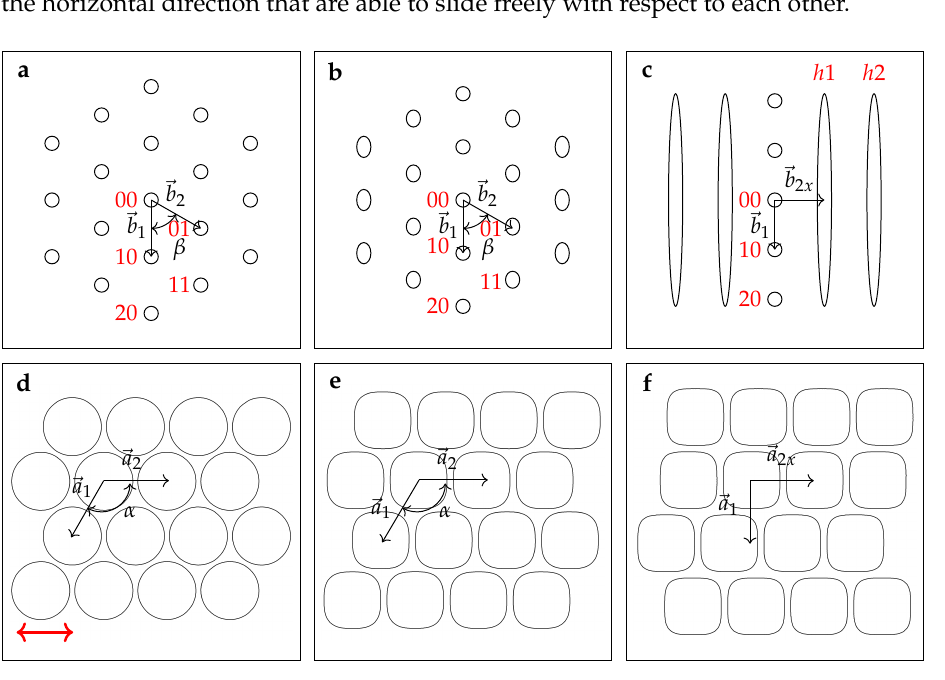
Figure 7. ( a – c ) The deduced structure factor S ( (cid:126) q ) in reciprocal space and ( d – f ) the corresponding lattices in real space for the ( a , d ) solid spherical, ( b , e ) hollow semi-cubic and ( c , f ) hollow cube-like superballs. Here (cid:126) b 1 and (cid:126) b 2 are the primitive reciprocal basis vectors, separated by angle β , and (cid:126) a 1 and (cid:126) a 2 , separated by angle α , are the corresponding primitive lattice vectors. For the cube-like superballs we have instead defined (cid:126) b 2 x as the horizontal component that is perpendicular to (cid:126) b 1 . The Bragg peaks are labelled on their left. The direction of the mechanical rubbing is indicated in the images using a red